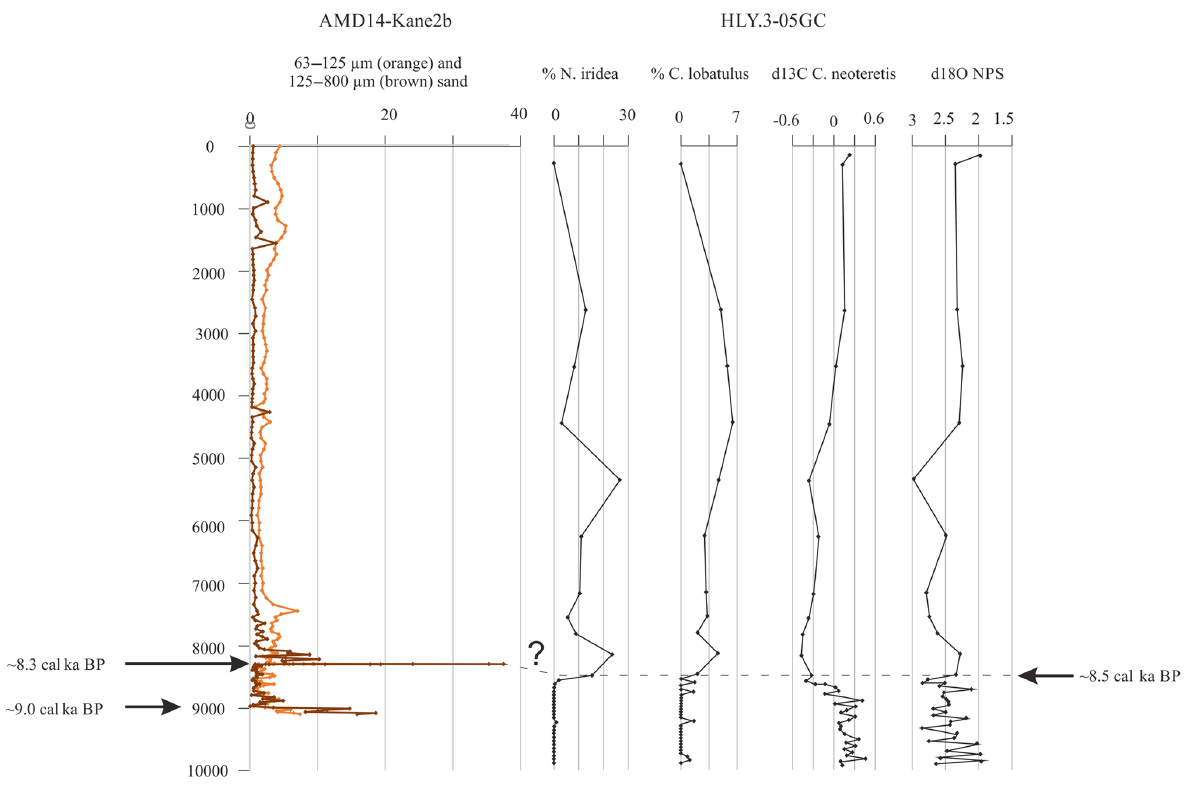
Figure 7. Comparison of sieved grain size data from AMD14-Kane2b and paleoceanographic proxies from HLY03-05CG in Hall Basin (Jennings et al., 2011). Radiocarbon ages presented in Jennings et al. (2011) were calibrated with (cid:49) = 240 ± 51 (Table S4 in the Supplement) years and the age model for core HLY03-05CG is a linear interpolation between the calibrated ages.